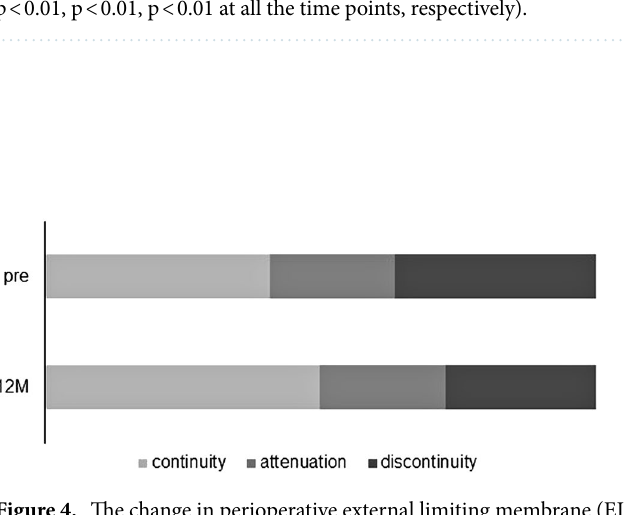
Figure 4. The change in perioperative external limiting membrane (ELM) status. In all eyes, the proportion of continuity, attenuation, and discontinuity was not statistically different between preoperative (9/5/8) and 12 months postoperative (11/5/6) (p =